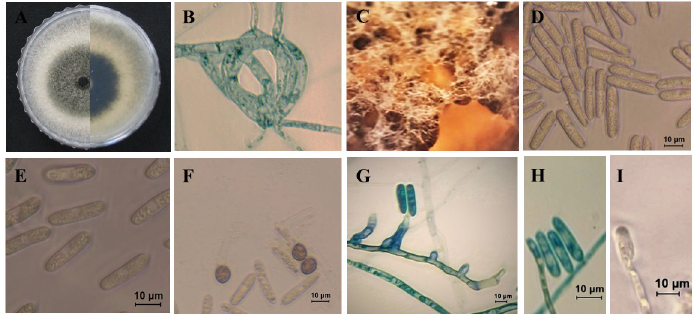
Fig 11. Morphological characteristics of C . ovetaense (isolate T72). A: Colony on PDA above and below. B: Hyphal coil C: Conidioma. D-E: Conidia. F: Appressoria. G-I: